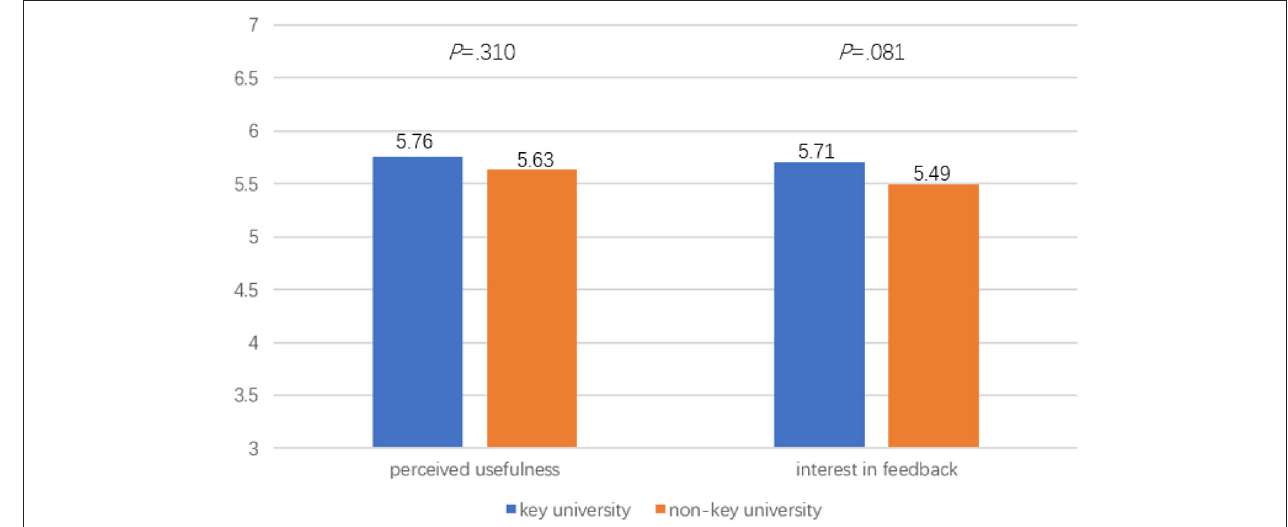
FIGURE 2 | Mean differences of feedback motivation between students from the key and non-key university.